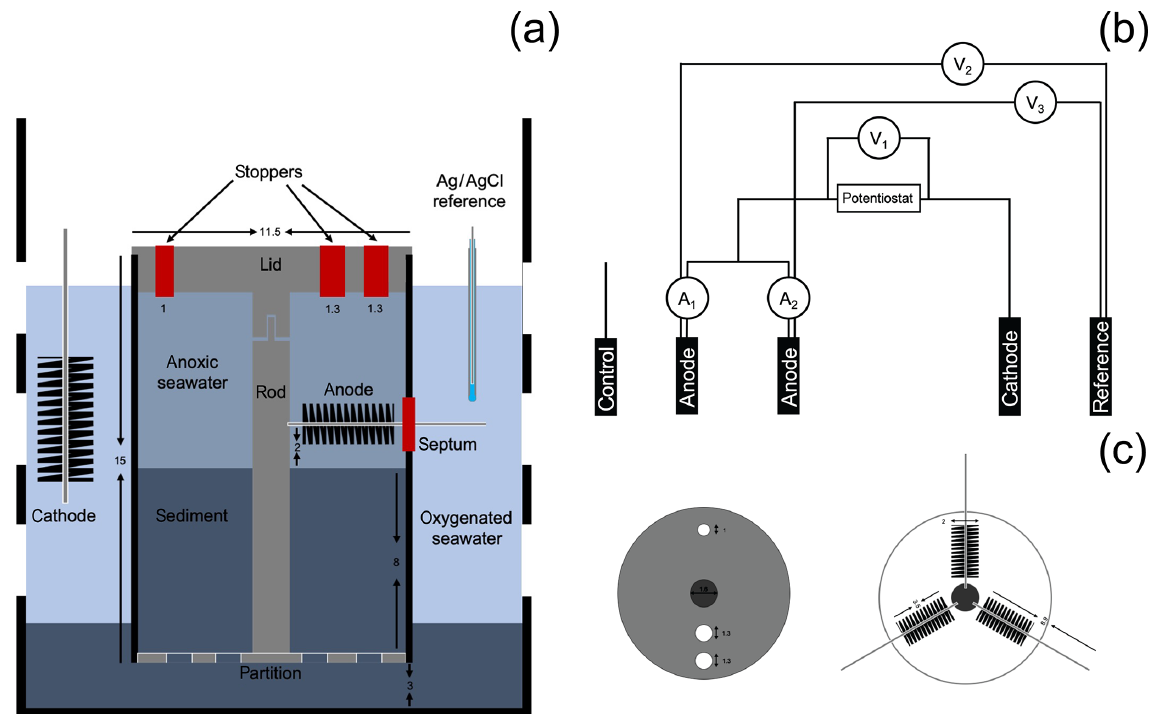
Figure 1. Schematic of the bioelectrochemical reactor design used in this study: (a) lateral view of the reactor, (b) electrical circuit of the reactor, and (c) bird’s-eye view of the reactor cap and electrode arrangement. Dimensions are in cm. A 1 and A 2 represent the current monitored in duplicate anodes, V 1 represents the potential monitored between the duplicate anodes and cathode, and V 2 and V 3 represent potentials monitored between the duplicate anodes and the reference